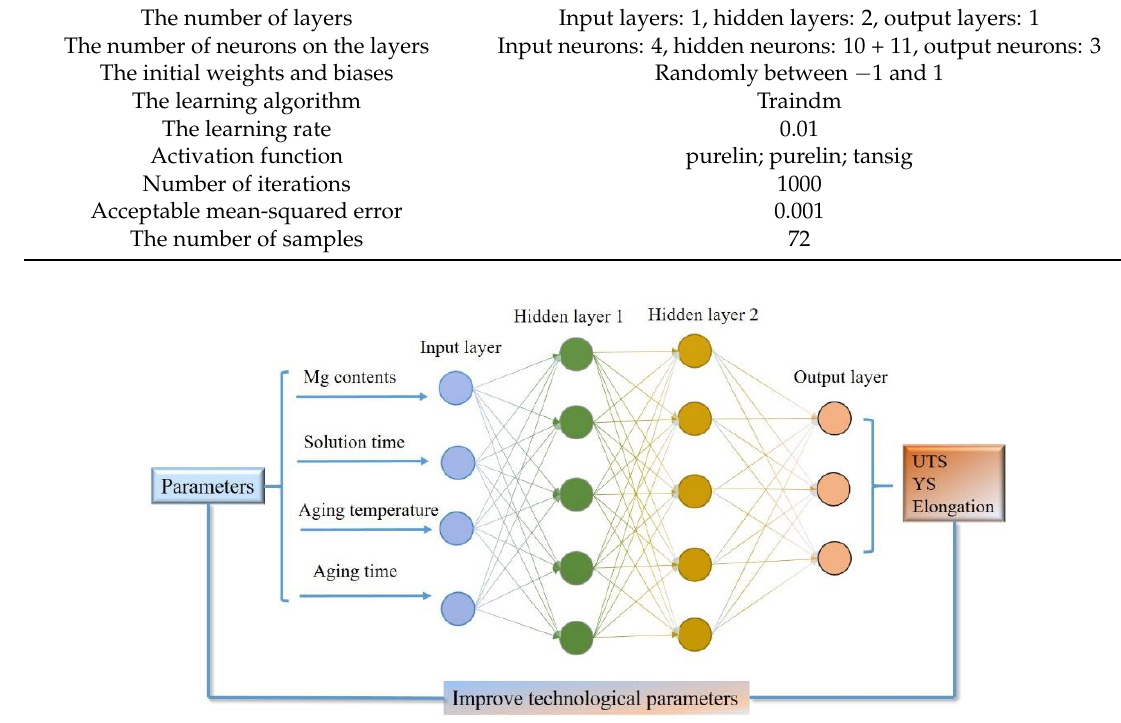
Figure 2. The artificial neural network designed for this study.